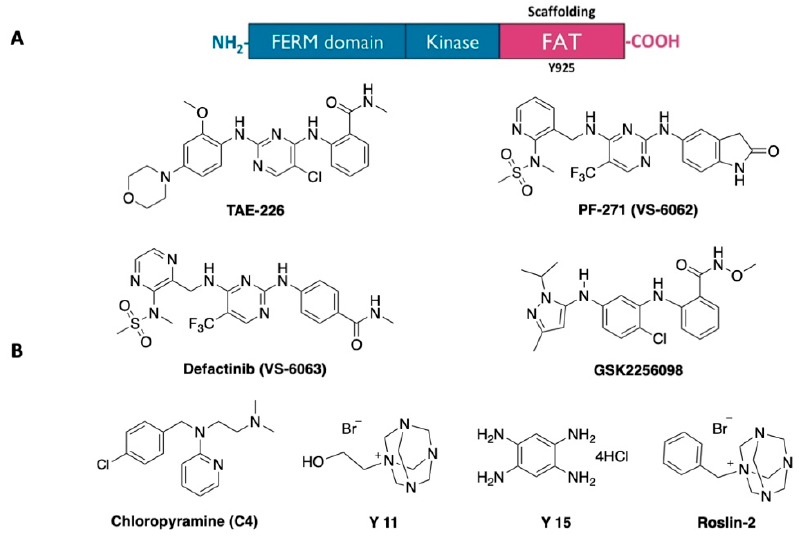
Figure 1. ( A ) Schematic representation of focal adhesion kinase (FAK); FERM is the N-terminal domain followed by the central kinase domain. The focal adhesion targeting domain (FAT) is the C-terminal part of the protein, showing key tyrosine phosphorylation site Y925. ( B ) Chemical structure of the kinase-dependent FAK inhibitors TAE-226, PF-271 (VS-6062), Defactinib (VS-6063), and GSK2256098; and the kinase-independent chloropyramine (C4), Y 15, Y 11, and Roslin-2 compounds.